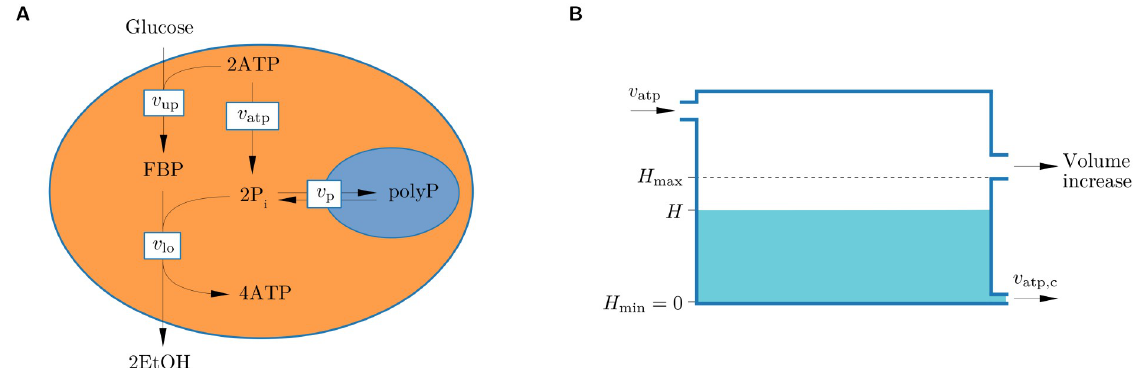
Fig 1. A model of a yeast cell with a simplified glycolysis pathway. (A) A generalized core model of yeast glycolysis [3] considers the intracellular concentrations of the glycolytic intermediate fructose-1,6-bisphosphate (FBP), ATP and inorganic phosphate (P i ), and four reactions (arrows): (i) a lumped upper glycolysis reaction that produces FBP from extracellular glucose with rate v up , (ii) a lumped lower glycolysis reaction that generates ATP and the waste product ethanol (EtOH) at rate v lo , (iii) ATPase reaction reflecting general ATP demand in the cell at rate v atp , and (iv) reversible phosphate transport between the cytosol and the vacuole at rate v p . PolyP refers to the vacuolar store of polyphosphate. (B) The flux through the ATPase reaction v atp and the associated cell growth rate can be visualized by water flow through a tank with two outlets. v atp is coupled to cell growth in a way that allows a cell to survive and recover from limited periods of negative energy balance (e.g., during metabolic imbalance or starvation). The coupling is mediated via cellular reserves, quantified by a variable H (cell health, depicted by the water level in the tank). A cell grows (increases in volume) when its health H is at the maximal value and v atp is larger than obligatory cellular maintenance cost v atp,c . When v atp is not sufficient to cover cellular maintenance cost, cell health decreases. The cell dies if its health drops to